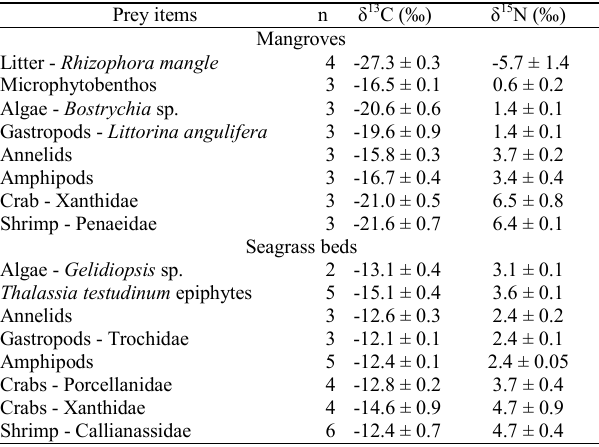
Table 1. Mean (± SD) isotopic signatures of prey items from mangrove ponds and seagrass beds. n: number of samples for stable isotope